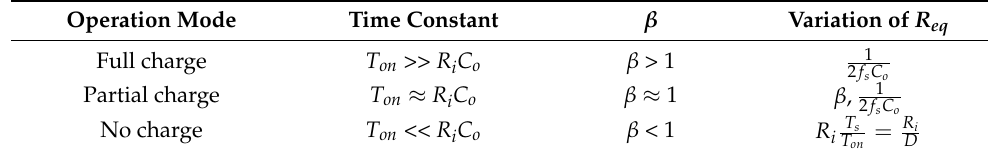
Table 4. Operation modes of SC converters.